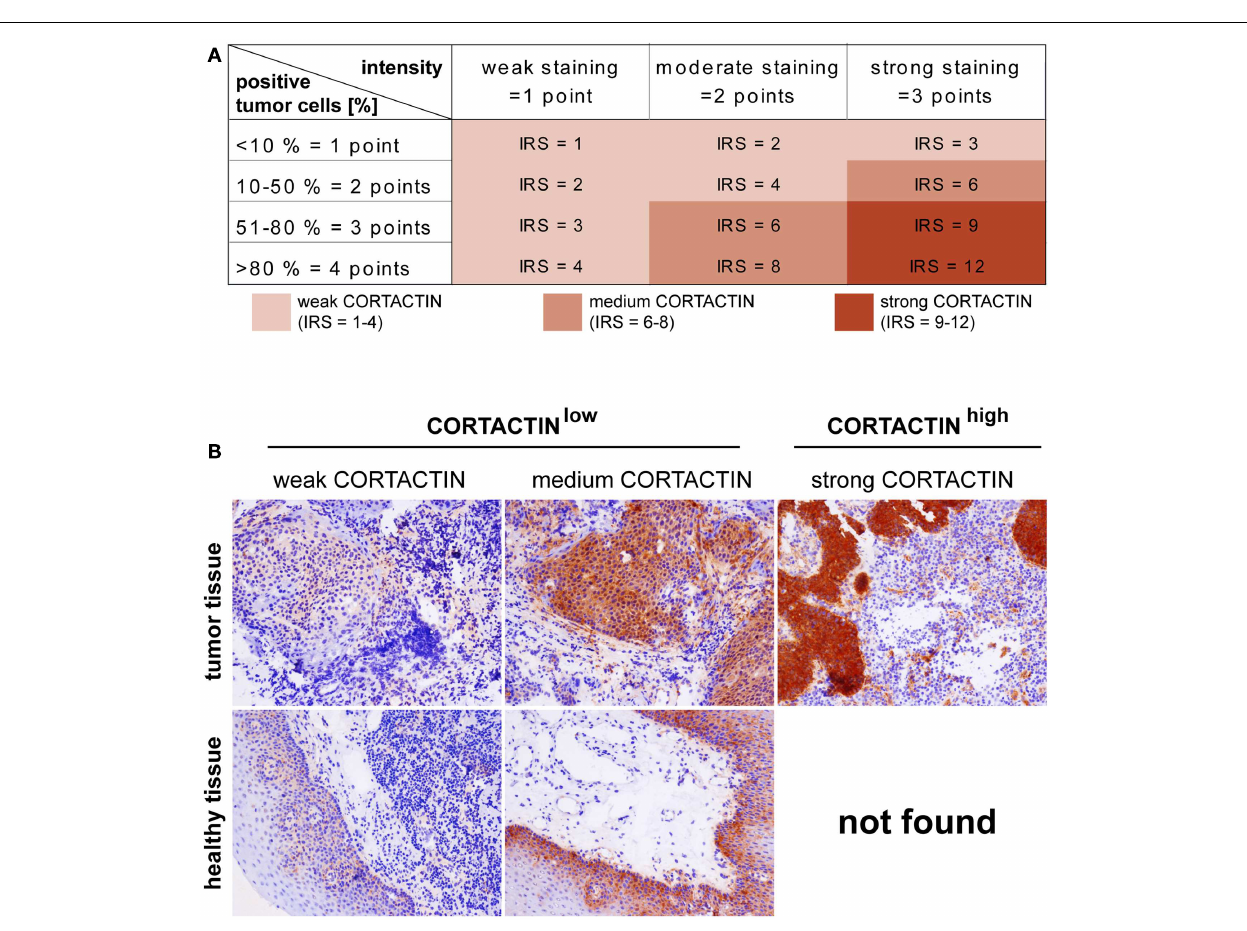
FIGURE 1 | CORTACTIN expression and scoring in tissue microarrays. Malignant orohypopharyngeal and healthy epithelial tissues were stained against CORTACTIN. (A) The immunoreactive score (IRS) was calculated as intensity of the staining reaction multiplied by the percentage of positive cells. Based on the IRS values, CORTACTIN was scored as weak , medium , and strong . (B) Representative micrographs indicating that